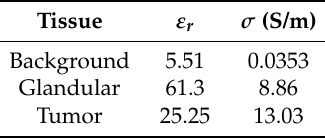
Table 2. Electrical properties ( ε r the relative permittivity, and σ the conductivity) of different breast tissue at 434